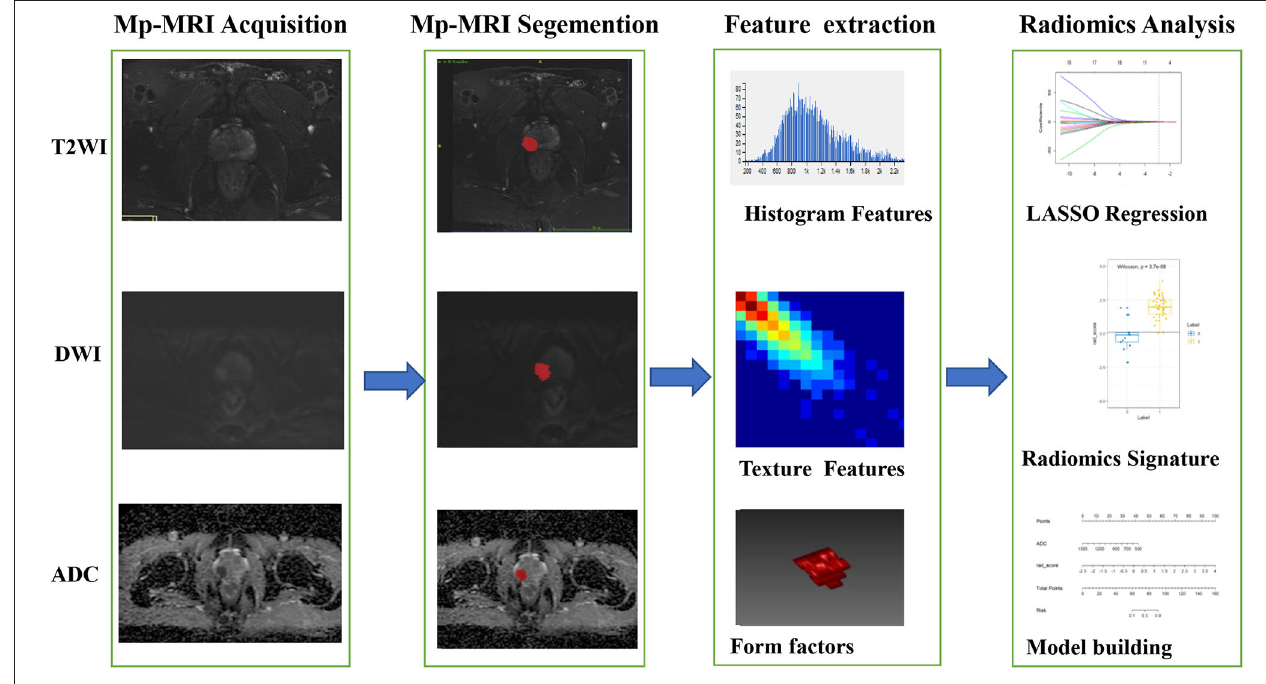
FIGURE 2 | The framework for the radiomic